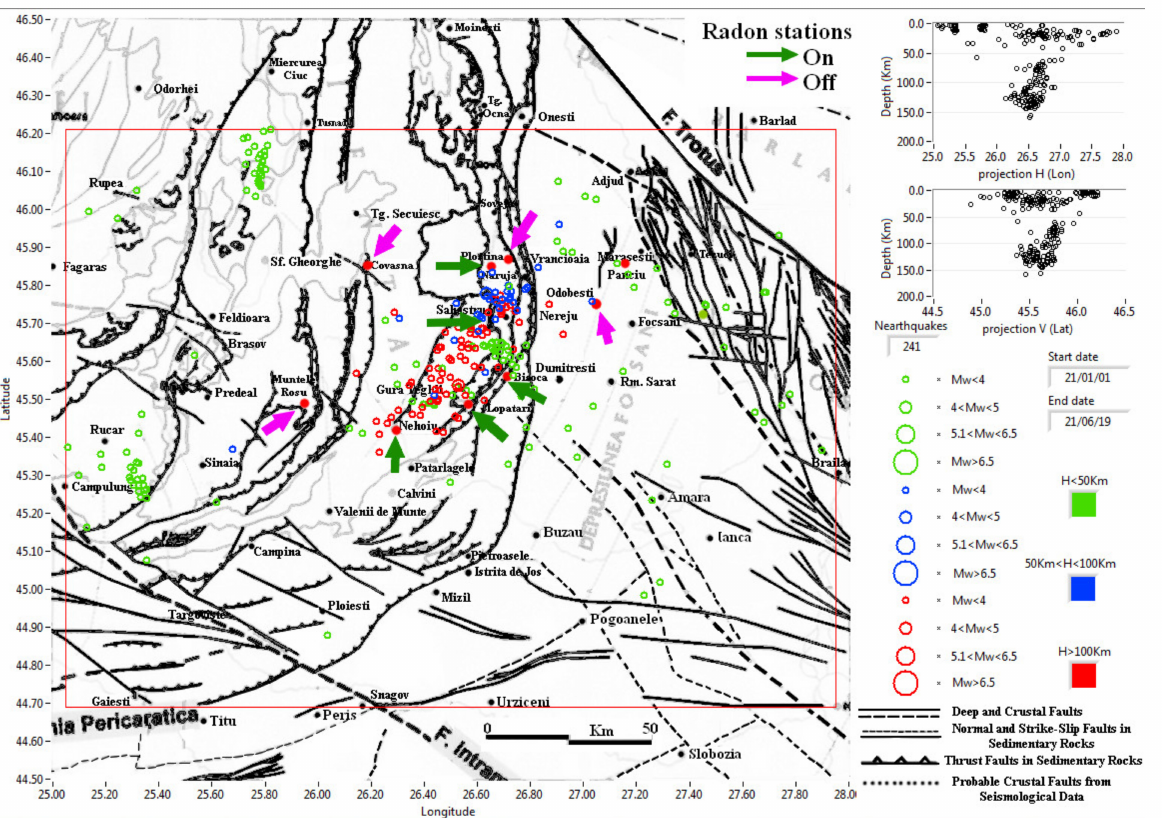
Figure 2. Vrancea faults and seismicity in 2021, radon monitoring